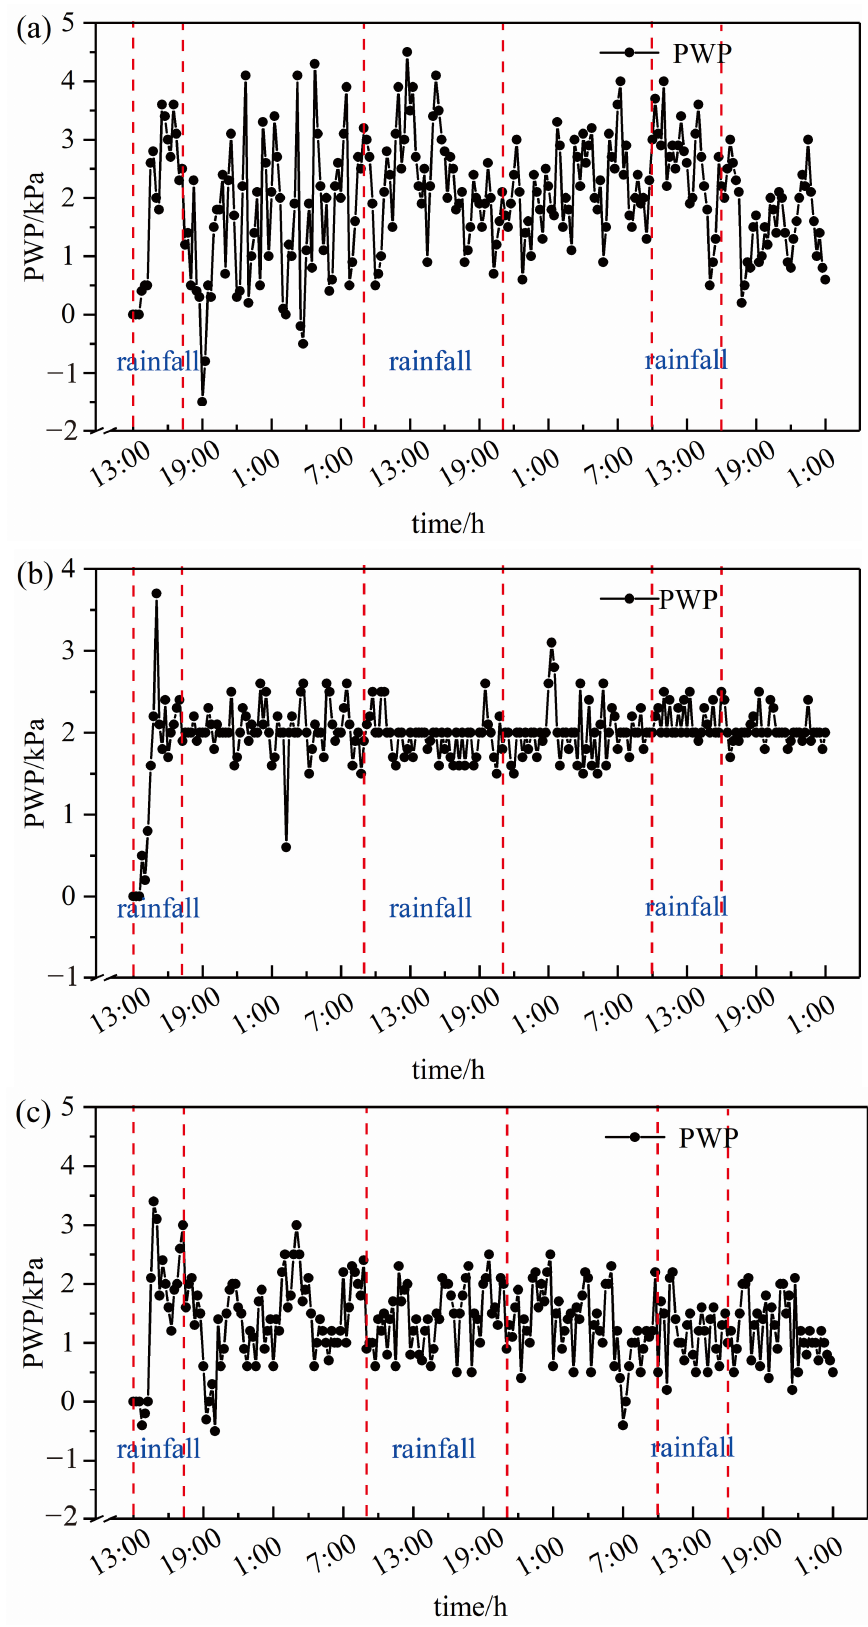
Figure 8. Time-varying curves of pore water pressure (PWP) at different depths under the first condition: ( a ) 40 cm, ( b ) 200 cm, and ( c ) 300 cm.